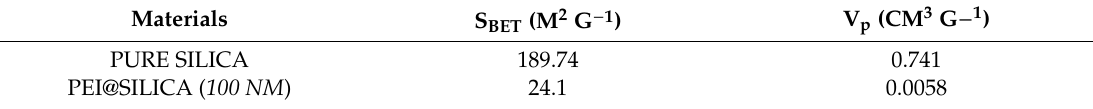
Figure 2. Nitrogen adsorption (closed symbols) and desorption (open symbols) isotherms for PEI@silica ( 100 nm ) sensing material. Table 1. Measured properties of silica nanoparticles before and after loading with PEI.